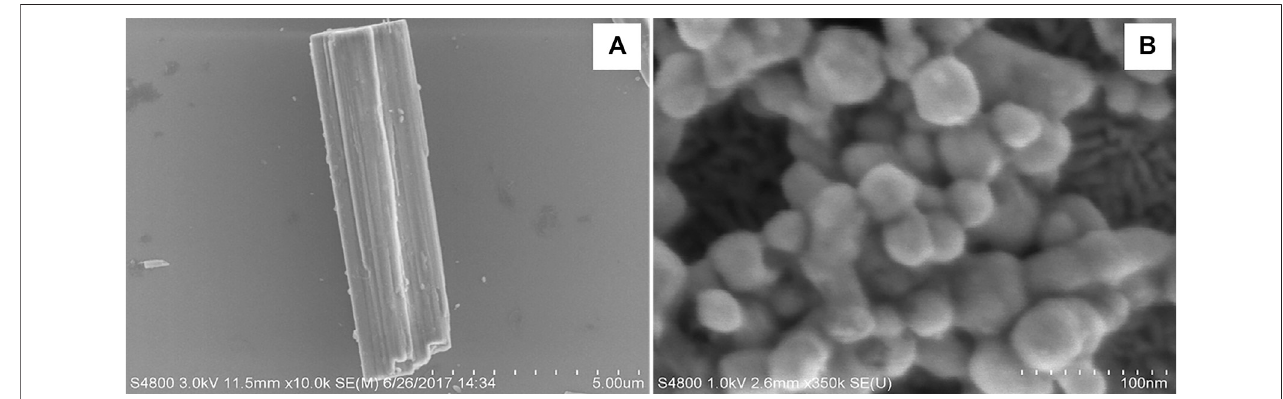
FIGURE1| Scanningelectronmicroscopeimagesshowingthesigni fi cantdifferencesinshapeandsizeofCuHARS(PanelA)andAgCysNPs(PanelB).Scalebarin (A) (cid:2) total length of 5.00 microns with 500 nm gradations indicated and scale bar in (B) (cid:2) 100 nm length with 10 nm gradations.